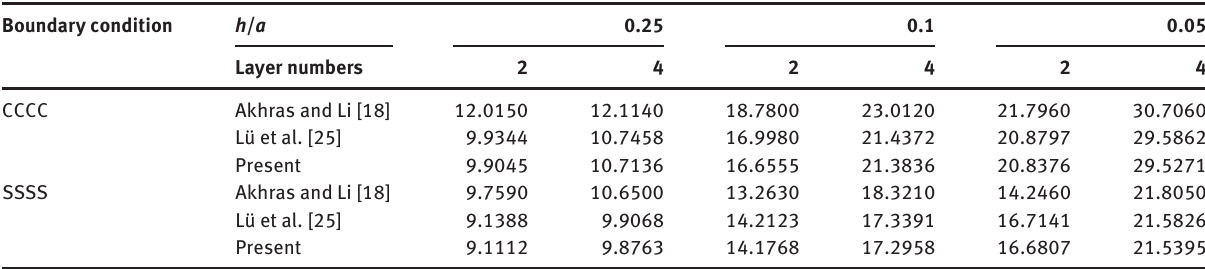
Table 2 Comparisons of the fundamental frequencies ˆ ω for antisymmetrical angle-ply square plates with the stacking sequences of (45/-45/ …